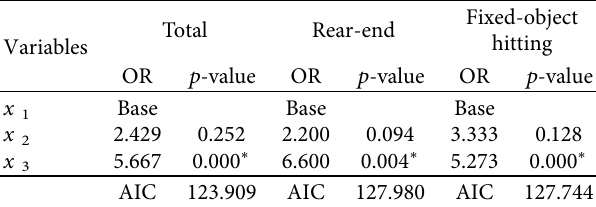
Table 3: Estimated results of the LR